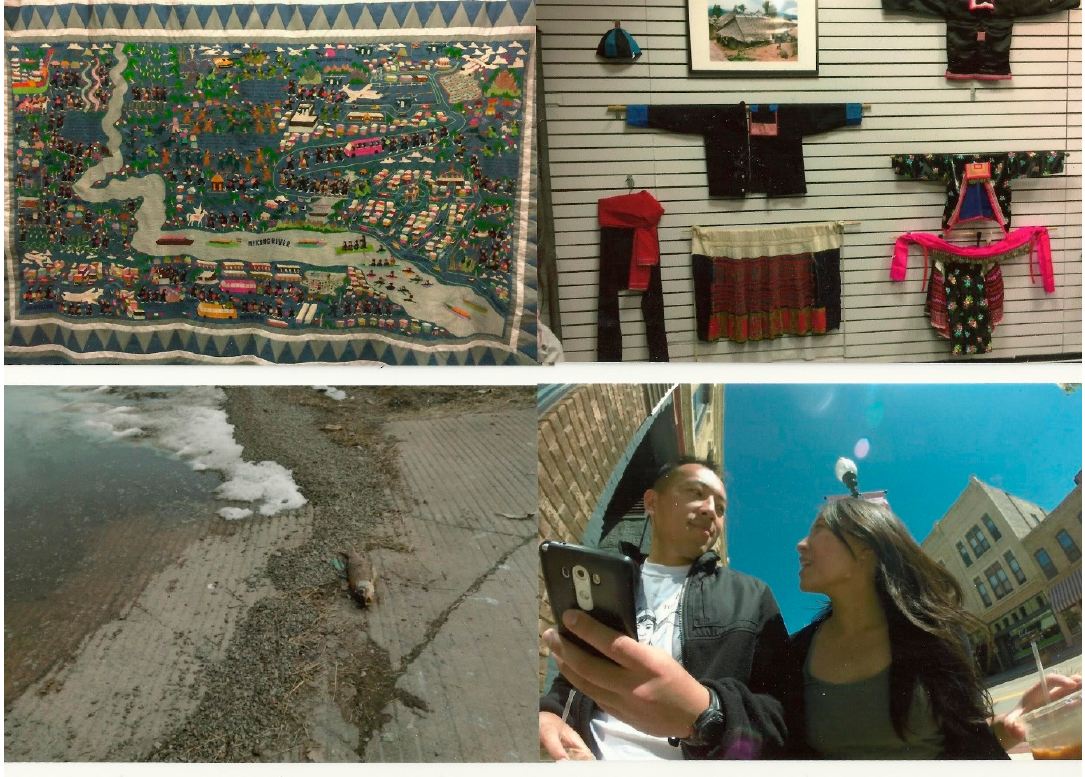
Figure 1. One resident with refugee background (RRB) was highly engaged in the process and took a number of photos in response to our instructions, including these.